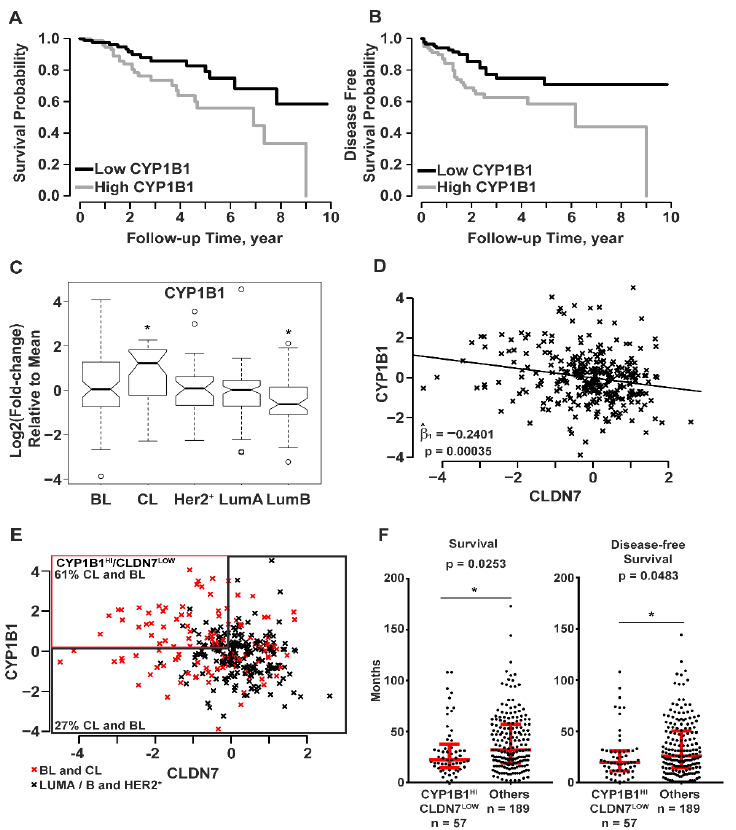
Figure 3. Patient tumor sample data (UNC337) indicate that CYP1B1 is associated with poor prognosis and reduced CLDN7 expression. ( A – F ) Data from breast cancer samples were grouped into the five intrinsic subtypes: basal-like (BL), claudin-low (CL), human epidermal growth factor receptor (HER2 + ), luminal A (LumA), and luminal B (LumB); UNC337 patient tumor sample database [5]. ( A , B ) Patient tumor sample data were separated into tertiles (104 high, 103 middle, and 103 low) of CYP1B1 RNA levels. ( A ) Survival probability was calculated using Kaplan-Meier analysis. Tumor patients with high CYP1B1 RNA levels had decreased probability of survival (Mantel-Cox test; p = 0.0115). ( B ) Disease-free survival was calculated using Kaplan-Meier analysis. Tumor patients with high CYP1B1 RNA levels have decreased probability of disease-free survival (Mantel-Cox test; p = 0.0111). ( C , D ) All 331 sample gene expression is shown as log2 (fold-change) relative to the mean expression of all samples. ( C ) Mean CYP1B1 RNA levels are elevated in CL tumor samples in comparison to all other samples. Boxplots show the inter-quartile range (IQR) within the box. The IQR is 25th percentile (Quartile 1) to 75th percentile (Quartile 3). The notch shows the 95% confidence interval of the median, and the whiskers include values within ± 1.5 IQR and 99.3% of the data points. Two-sample t -test ( p ≤ 0.05) of the means were corrected for multiple comparisons using Bonferroni’s correction. ( D ) CYP1B1 RNA levels predict CLDN7 RNA levels The coefficient of the linear regression line, Beta one hat ( ˆ β 1 ), is the estimate of the slope of the line that best fits the data points. The significance of this value was determined by t -test. ( E ) Combined BL and CL tumor samples contain more CYP1B1 HI /CLDN7 LOW samples than combined (LumA+ B+ HER2 + ) samples. Samples with >10% increase in CYP1B1 RNA levels and >10% decrease in CLDN7 RNA levels were classified as CYP1B1 HI /CLDN7 LOW relative to RNA levels in all other samples. Sixty- one percent of CYP1B1 HI /CLDN7 LOW samples were subtyped as CL or BL, while only 27% of all other samples were CL or BL. ( F ) Patients with CYP1B1 HI /CLDN7 LOW have decreased overall survival and disease-free survival. Red lines and whiskers show the median ± IQR. The * indicates a significant difference ( p ≤ 0.05) from comparison of CYP1B1 HI /CLDN7 LOW to all other samples by the Mann-Whitney